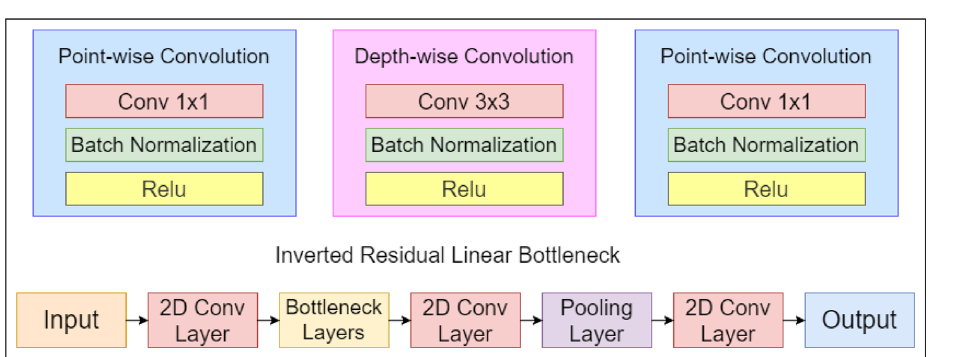
Figure 9. Block diagram illustration of the Efficientnet model used in the proposed HAR framework.